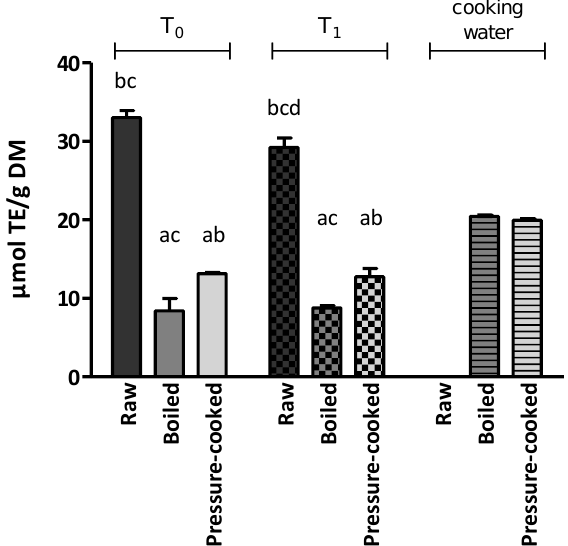
Figure 2. Antioxidant activity of Lenticchia di Castelluccio di Norcia PGI at T 0 , T 1 and its cooking water assessed by the DPPH assay. The results are expressed as the mean ± standard error of the mean. Statistical significance: p < 0.05. a vs. raw; b vs. boiled; c vs. pressure-cooked; d vs. T 0 .